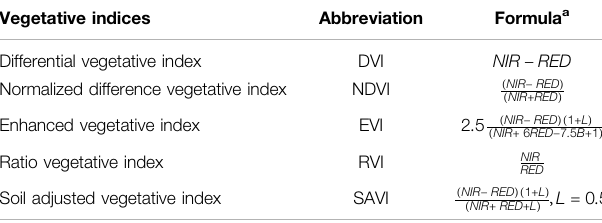
TABLE 4 | Types of spectral vegetative indices